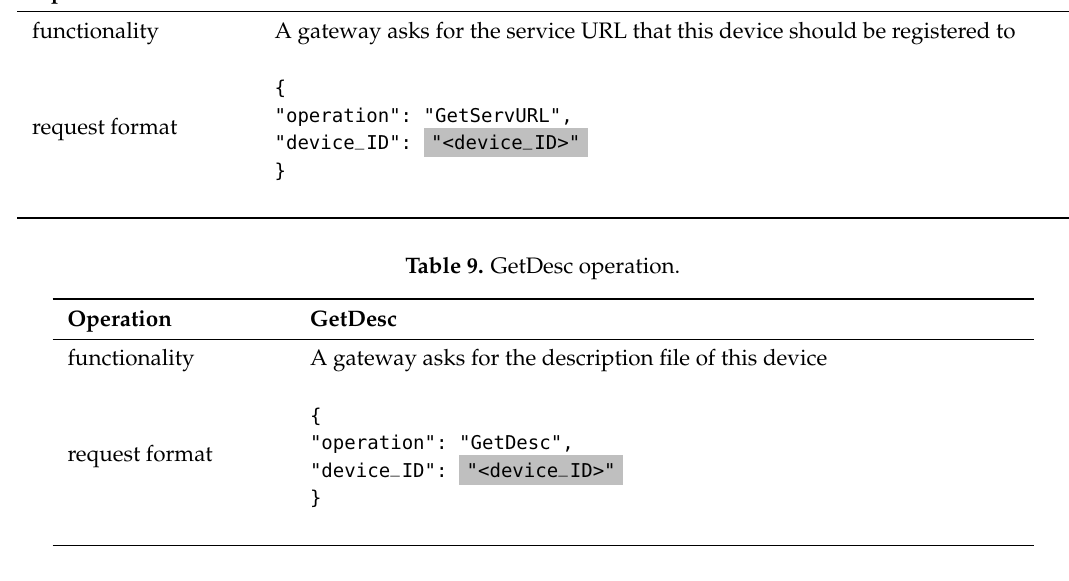
Table 10. GetServURLandDesc operation.